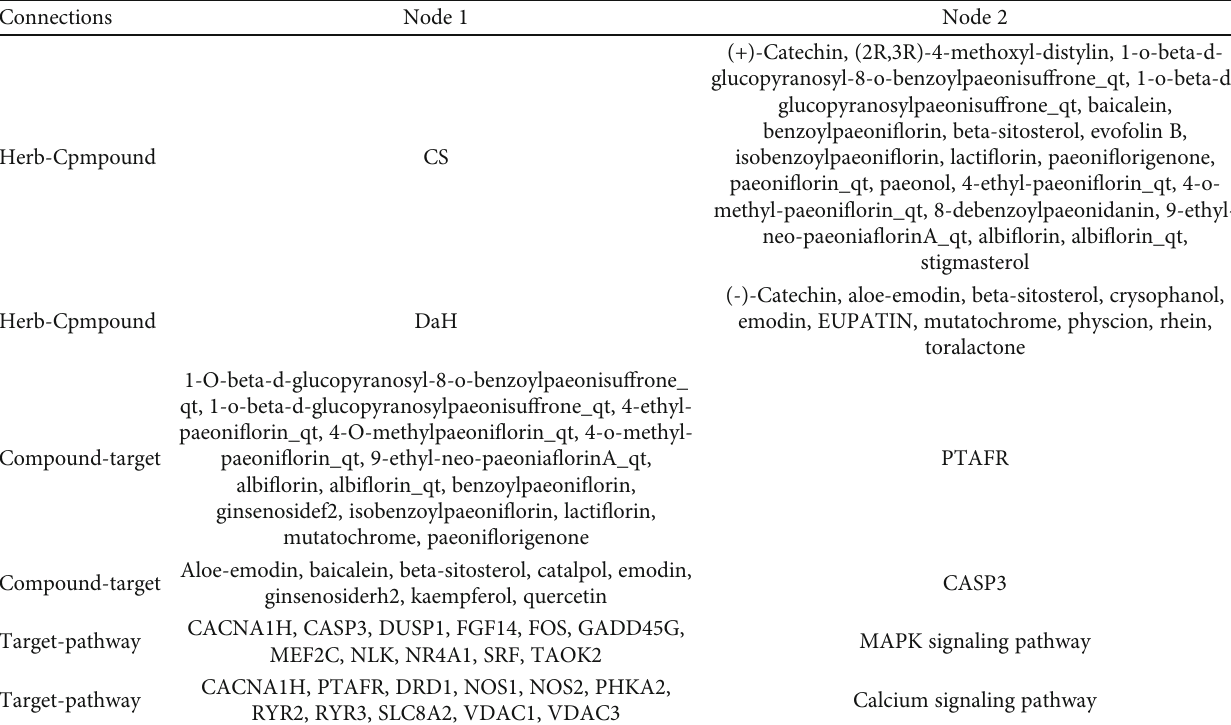
Table 5: Details of connections of important nodes in the H-C-T-P